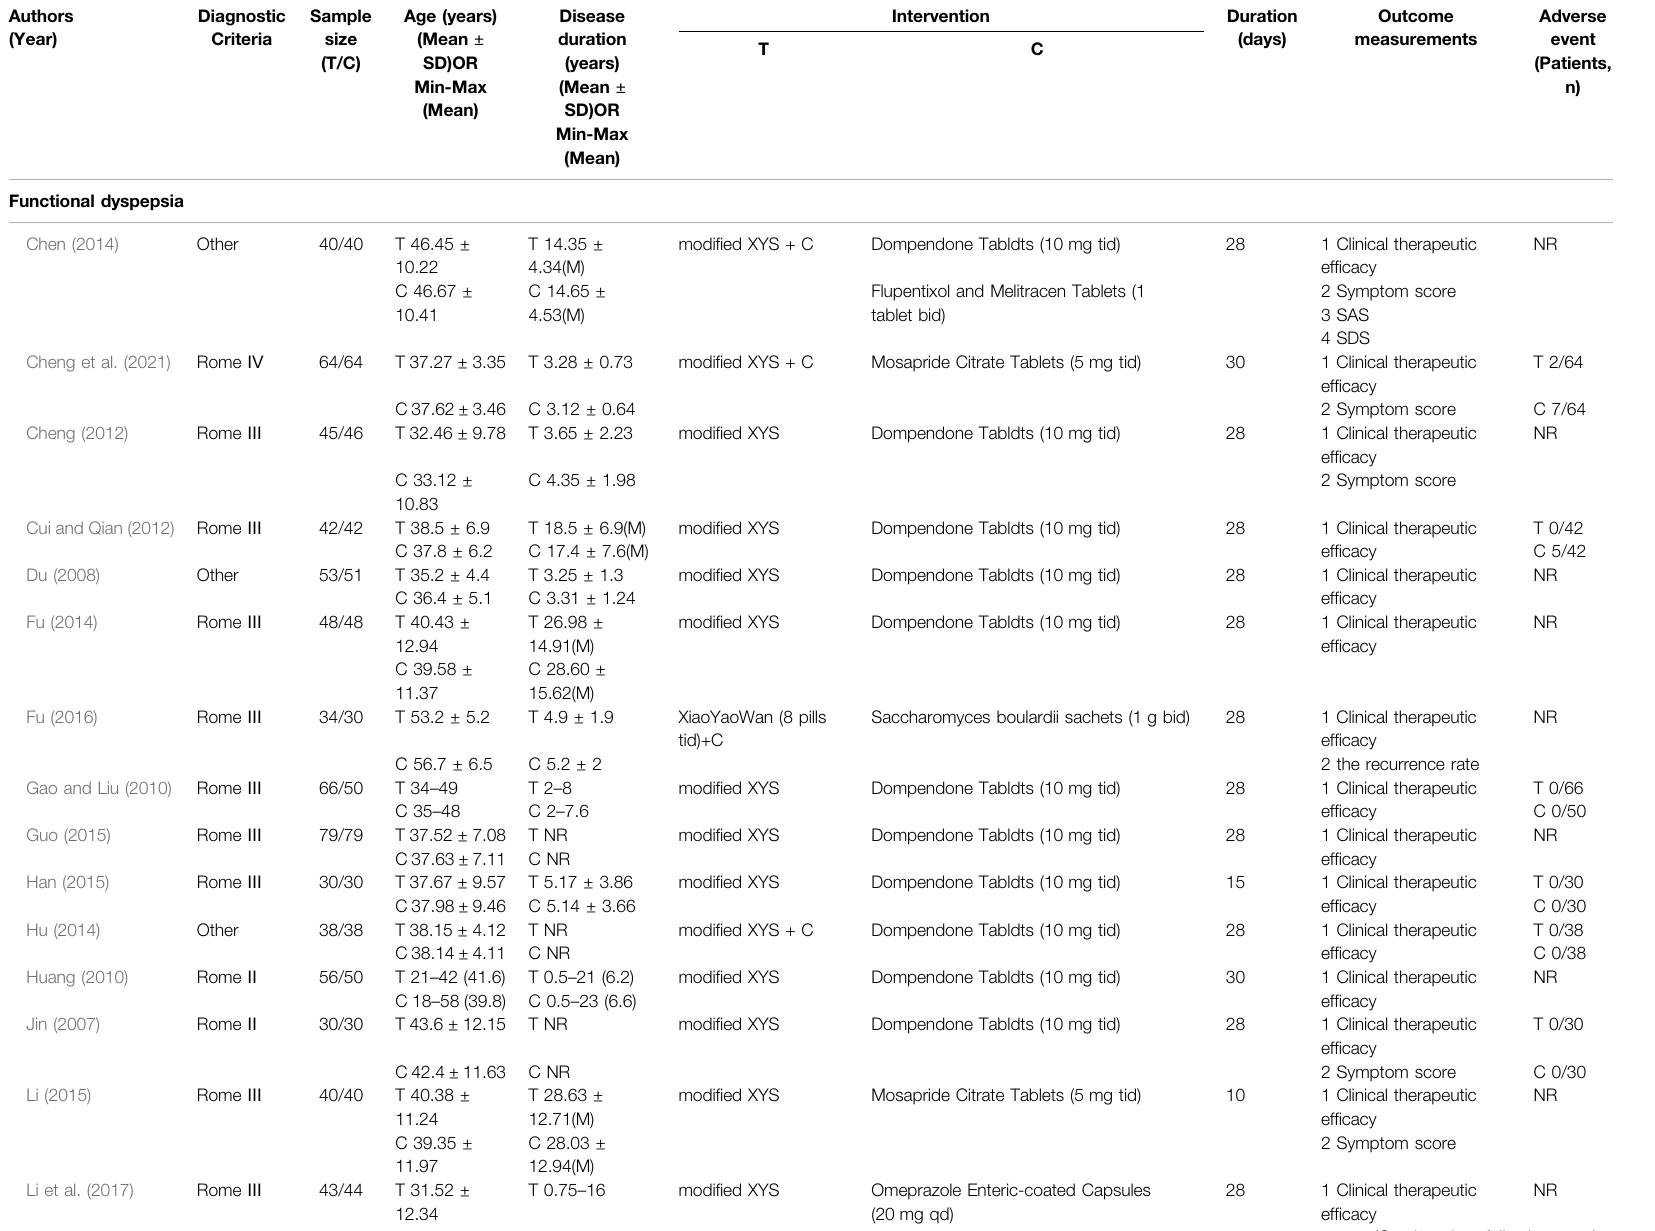
TABLE 1 | Characteristics of the included